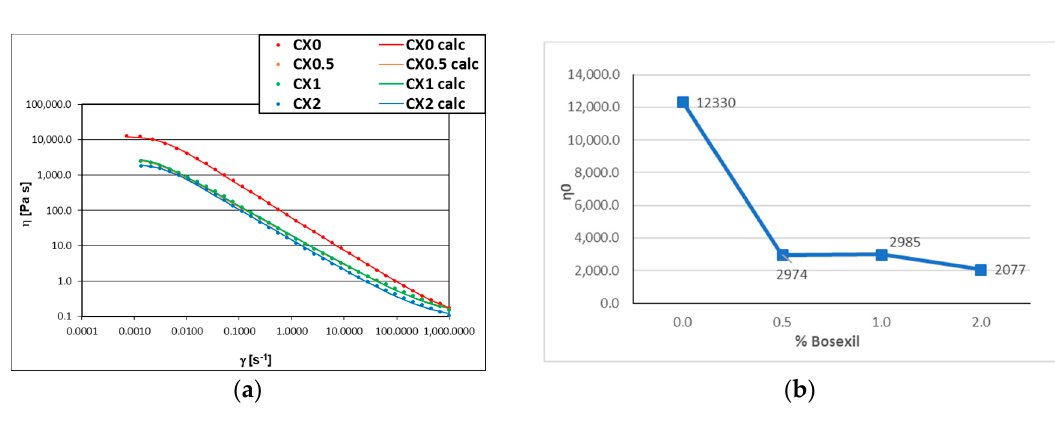
Figure 1. ( a ) Viscosity trends (experimental and fitted with Carreau-Yasuda model data) vs. shear rate of CX0, CX0.5, CX1, CX2 samples; ( b ) η 0 values as a function of different concentration of Bosexil ® (0%, 0.5%, 1%, 2%).